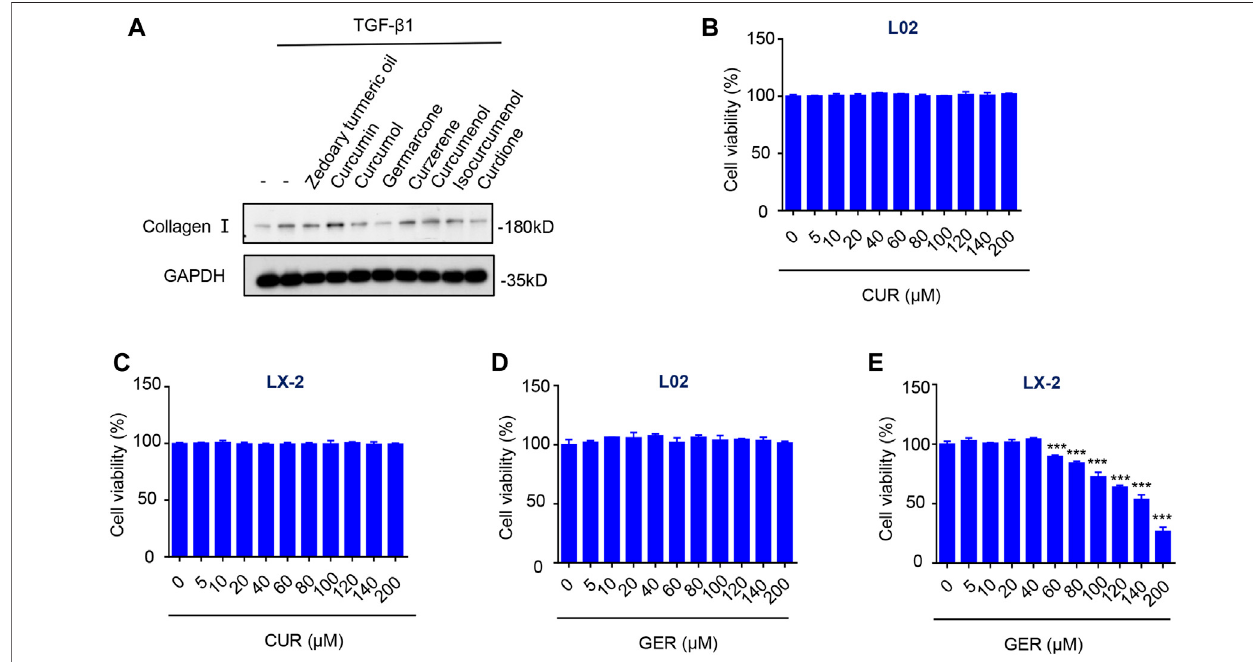
FIGURE 1 | Screening the effective components in zedoary turmeric oil which inhibit the activity of HSCs. (A) LX-2 cells were treated with Zedoary turmeric oil (0.2 μ L/ml) and Curcumin, Curcumol, Germarcone (GER), Curzerene, Curcumenol, Isocurcumenol, and Curdione (CUR) (40 μ M) for 25 h, and then were stimulated by TGF- β (10 ng/ml)for24 h.TheexpressionofcollagenIwasdetected bywesternblot,andGAPDHwasusedastheloadingcontrol. (B) L02cellsweretreatedwithCUR for24 h,thenthecellviabilitywasdetectedbyCCK-8( n (cid:2) 3). (C) LX-2cellsweretreatedwithCURfor24 h,thenthecellviabilitywasdetectedbyCCK-8( n (cid:2) 3). (D) L02 cells were treated with GER for 24 h, then the cell viability was detected by CCK-8 ( n (cid:2) 3). (E) LX-2 cells were treated with GER for 24 h, then the cell viability was detected by CCK-8 ( n (cid:2) 3). All the results were compared with control group. All data are presented as means ± SEM. *** p < 0.001 vs. the control group.